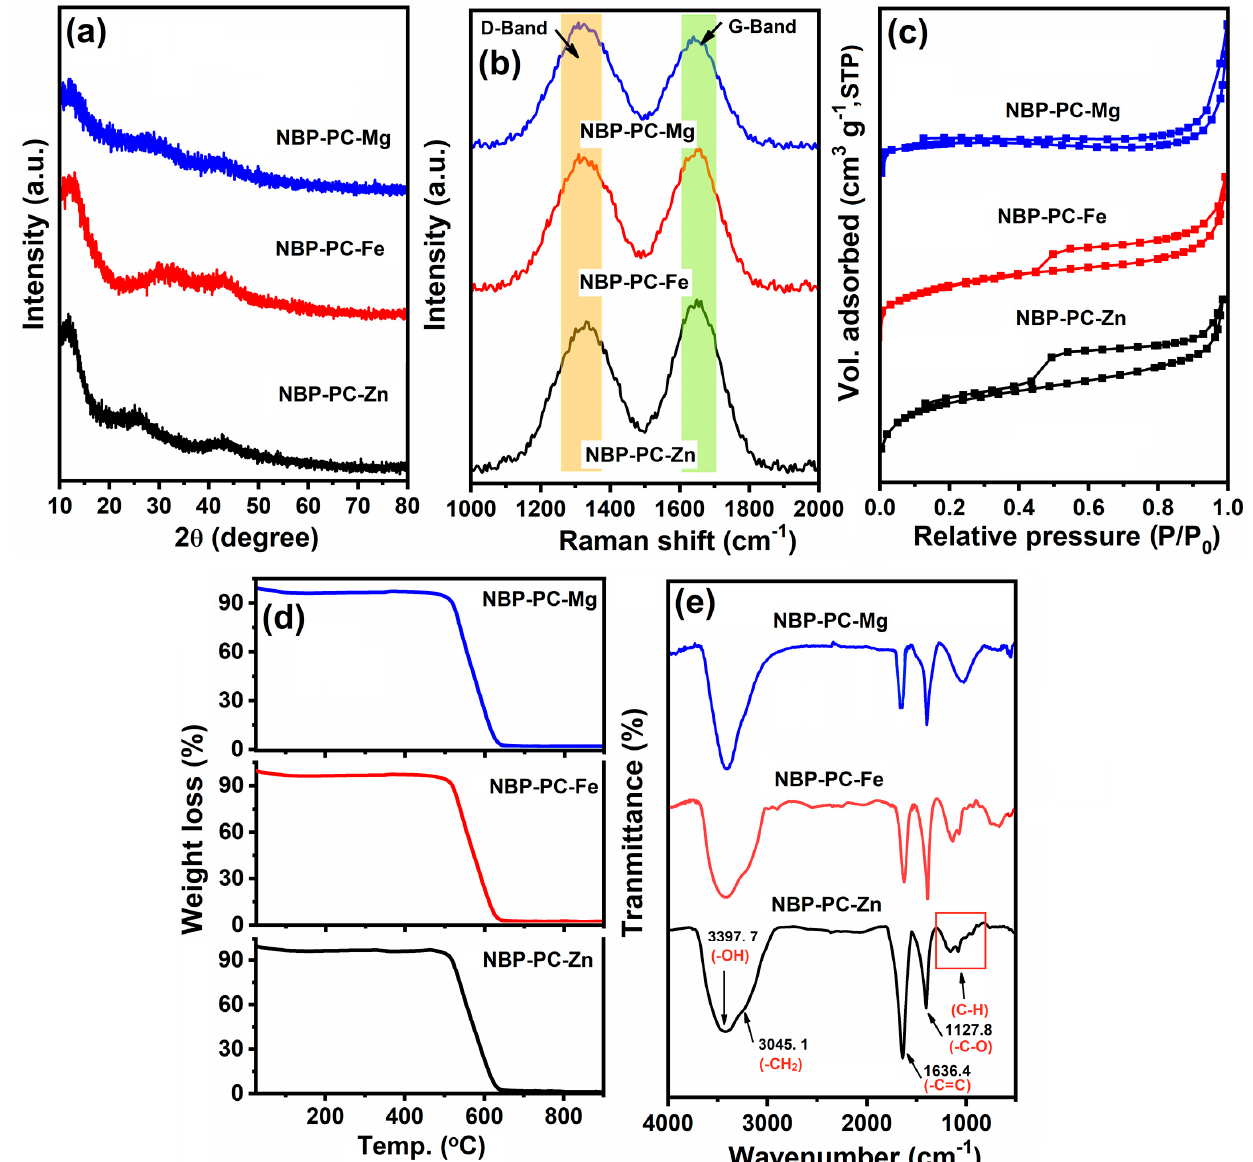
Figure 1. ( a ) XRD diffractogram, ( b ) Raman spectra, ( c ) N 2 -adsorption/desorption isotherms, ( d ) TGA profiles, and ( e ) FT-IR spectra of NBP-PC-Mg. NBP-PC-Fe, and NBP-PC-Zn samples.